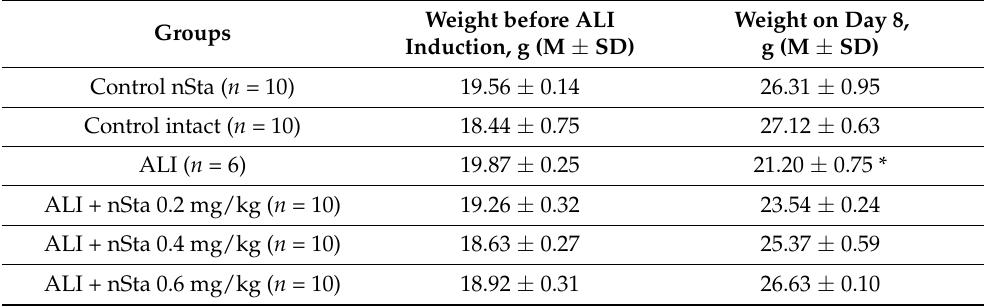
Table 2. Body weights of experimental animals.